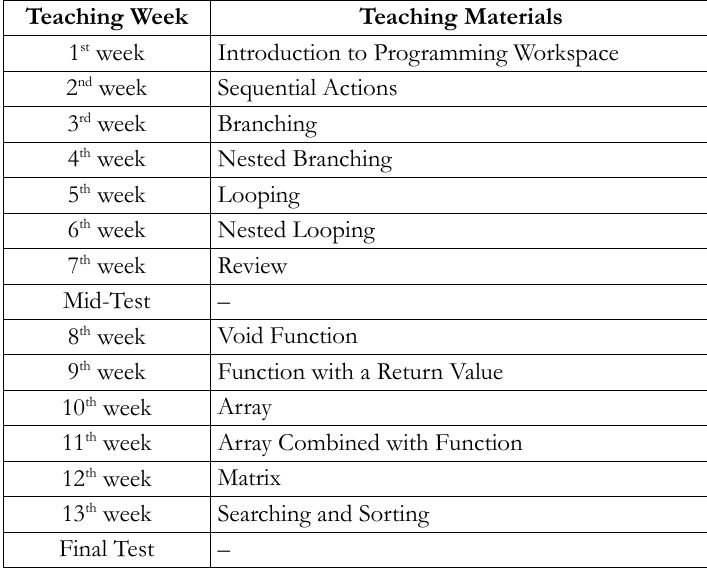
Table 2. Teaching